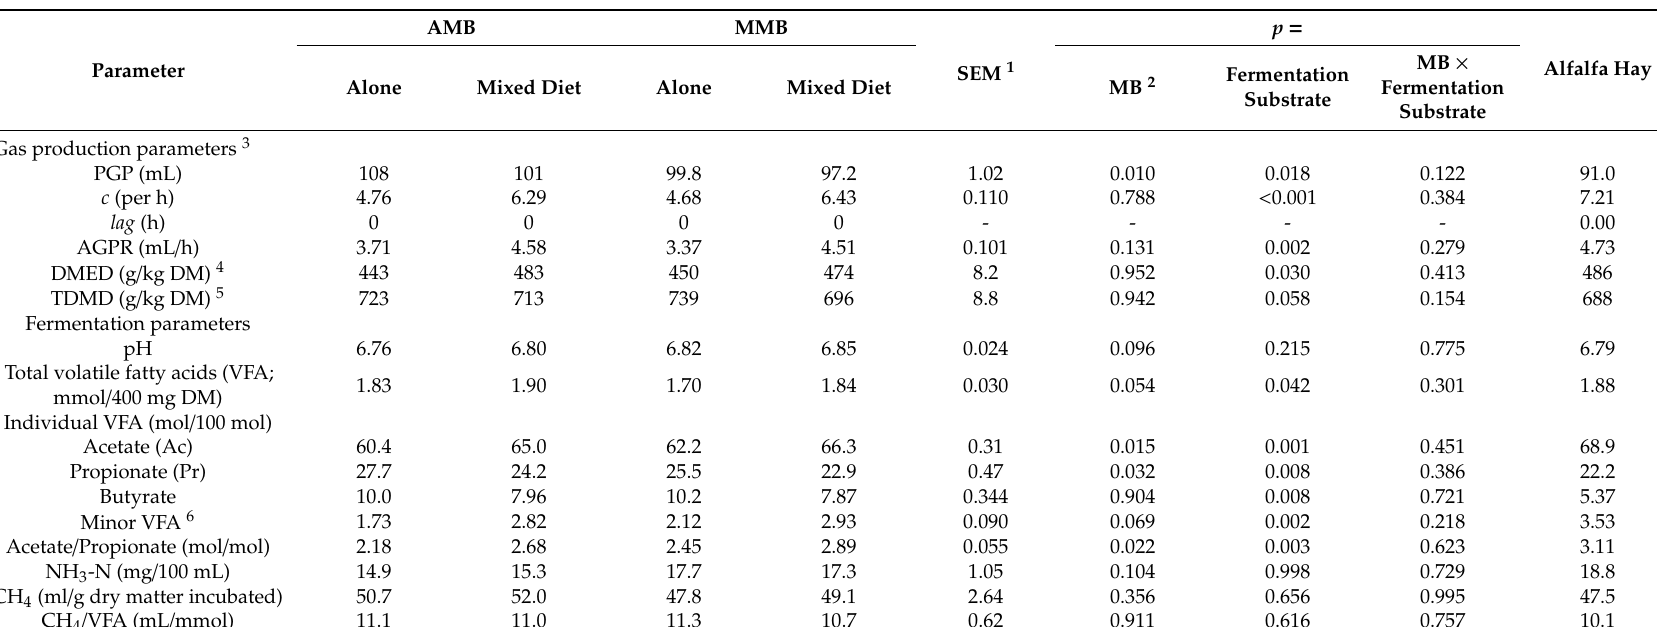
Table 5. Gas production parameters, dry matter e ff ective degradability (DMED) and true dry matter digestibility (TDMD) in 144 h incubations and fermentation parameters in 24 h incubations of multi-nutrient blocks containing avocado (AMB) or mango (MMB) wastes (pulp:peels) incubated either alone or mixed 1:1 with alfalfa hay with bu ff ered ruminal fluid from goats (Experiment